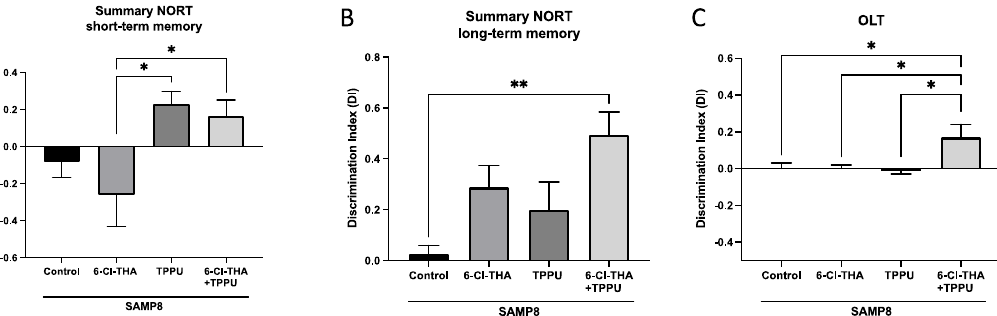
Figure 1. Effects of the drug combination and monotherapies on cognitive performance in SAMP8 mice. ( A ) Short-term memory test at 2 h. ( B ) Long-term memory test at 24 h. ( C ) OLT. Results are expressed as a mean ± SEM. SAMP8 control, n = 8; SAMP8 treated with the TPPU (1 mg/kg/day), n = 8; SAMP8 treated with 6-Cl-THA (1 mg/kg/day), n = 8; SAMP8 subjected to co-treatment with TPPU (1 mg/kg/day) plus 6-Cl-THA (1 mg/kg/day), n = 8. Groups were compared by a one-way ANOVA test and post-hoc Tukey’s test. * p < 0.05; ** p < 0.01. Abbreviations: 6-Cl-THA: 6-chlorotacrine; NORT = novel object recognition test; OLT = object location